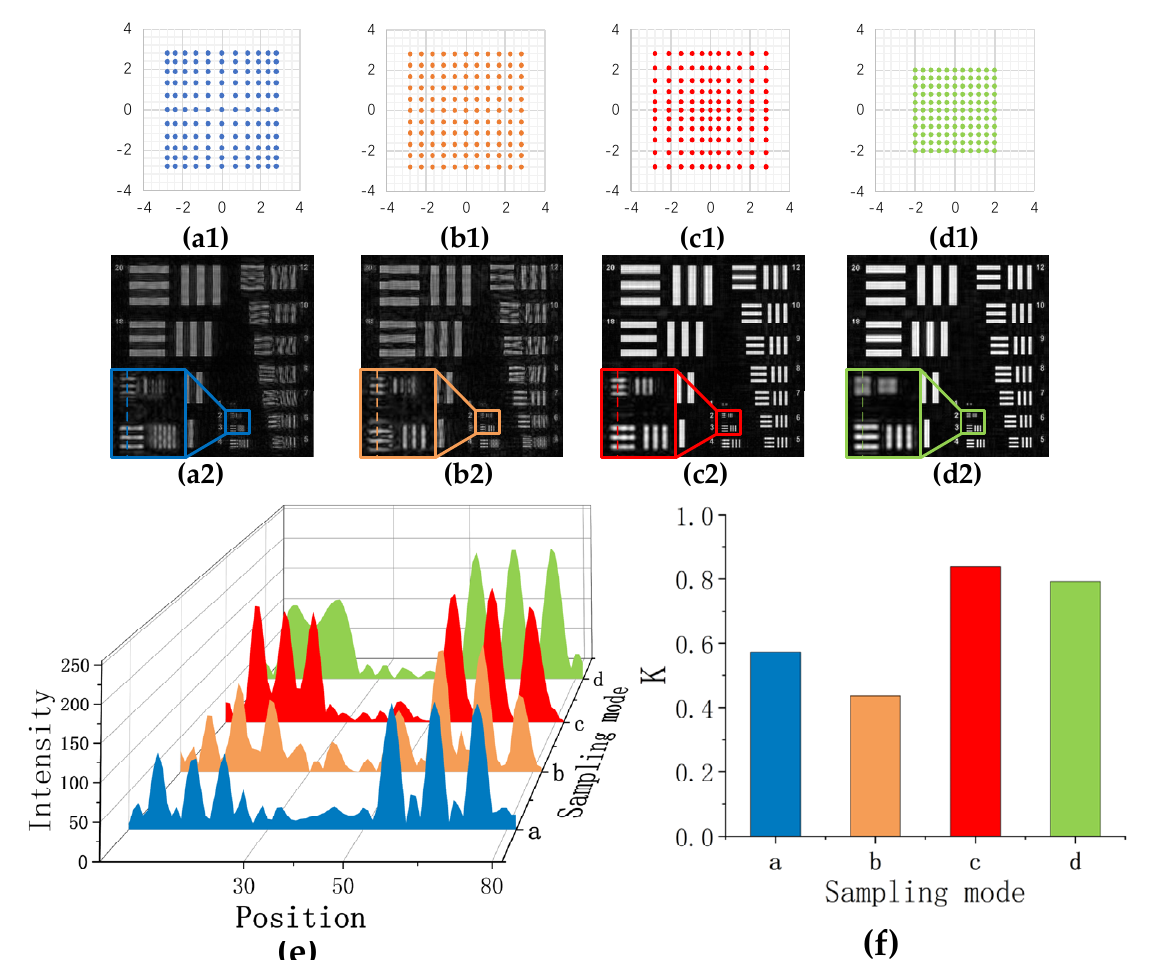
Figure 3. Different sampling modes, reconstructed images, and analysis. ( a1 , c1 ) Non-uniform sampling, where ( a1 ) has a low overlap rate in the center and cross-hair area, and a high overlap rate away from the center and cross-hair area. ( c1 ) Contrary to ( a1 ), ( b1 , d1 ) are uniform sampling modes. ( a2 − d2 ) are the corresponding image reconstruction results and partial enlarged images. ( e ) Pixel intensity distribution map of the horizontal stripes at group numbers 2 and 3 intercepted at the drawn line. ( f ) The structural similarity values K corresponding to different reconstructed images.